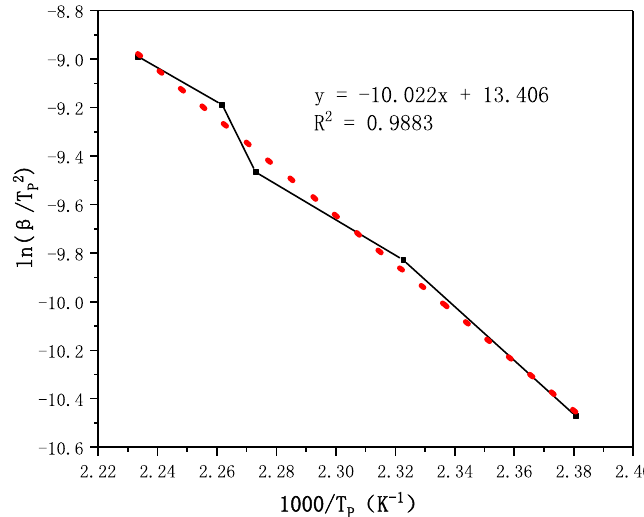
Figure 5. Fitting Kissinger method results of 1-nitroso-2-naphthol.